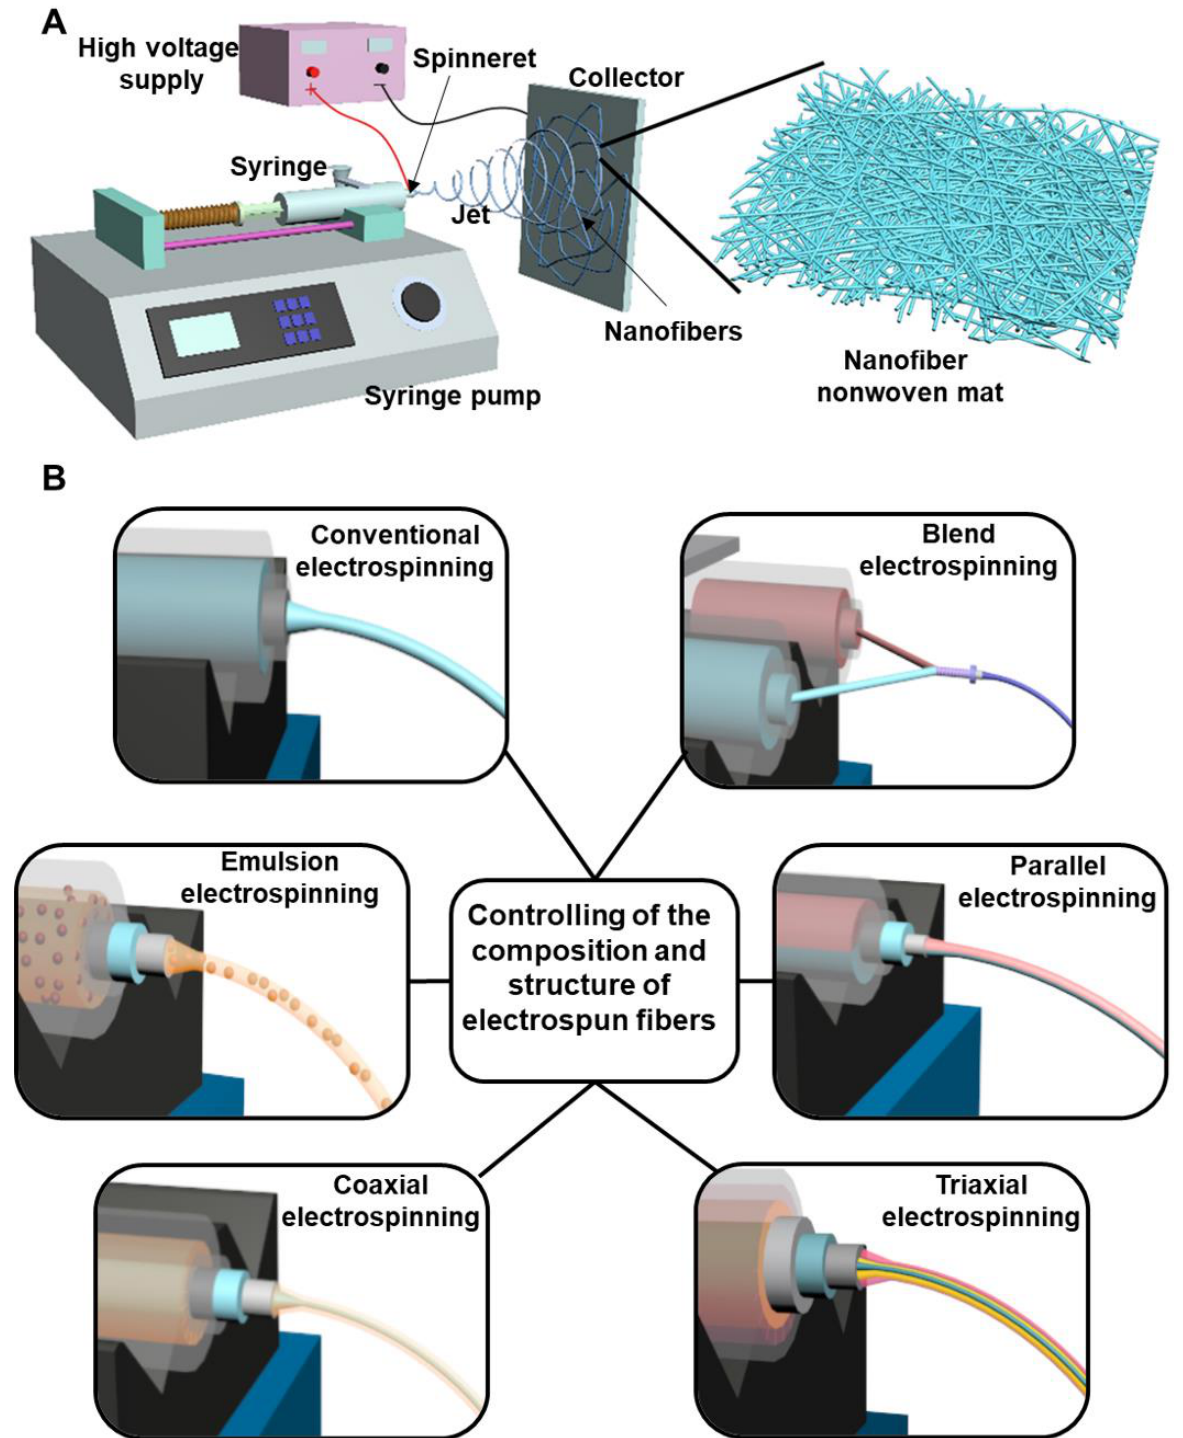
Figure 3. ( A ) Schematic of a conventional electrospinning device. ( B ) Schematic of some representative modified electrospinning strategies to control the composition and structure of electrospun fibers.